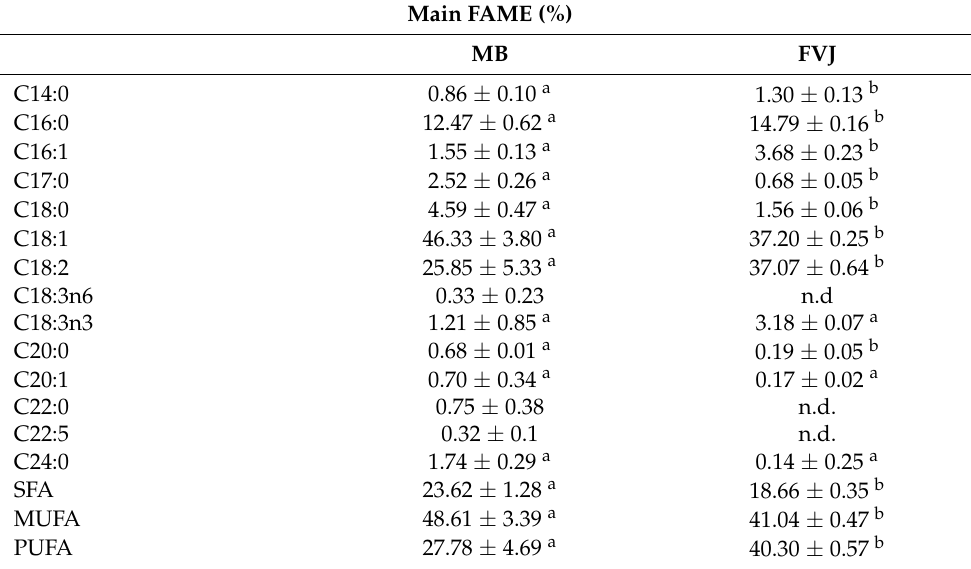
Table 8. Fatty acid methyl ester profile of Chlorella protothecoides biomass grown in modified Bristol and fruit and vegetable juices medium in fed-batch reactor